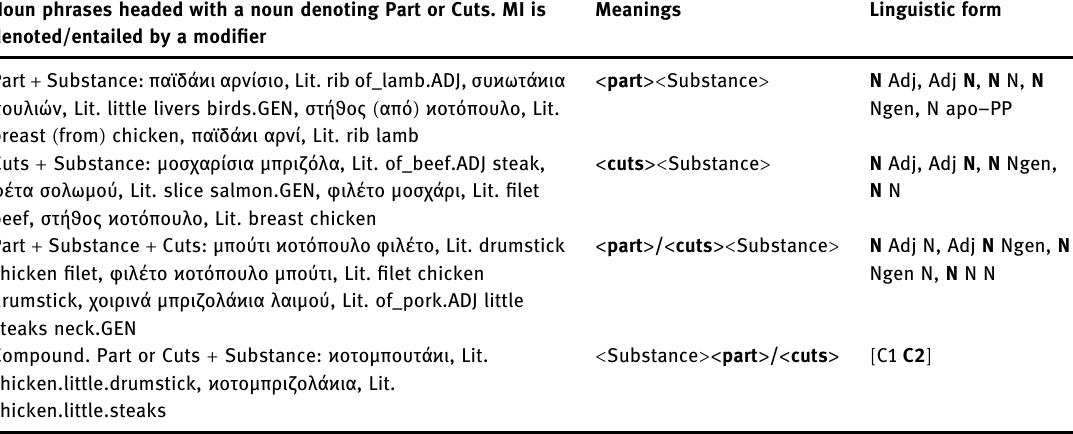
Meanings Linguistic